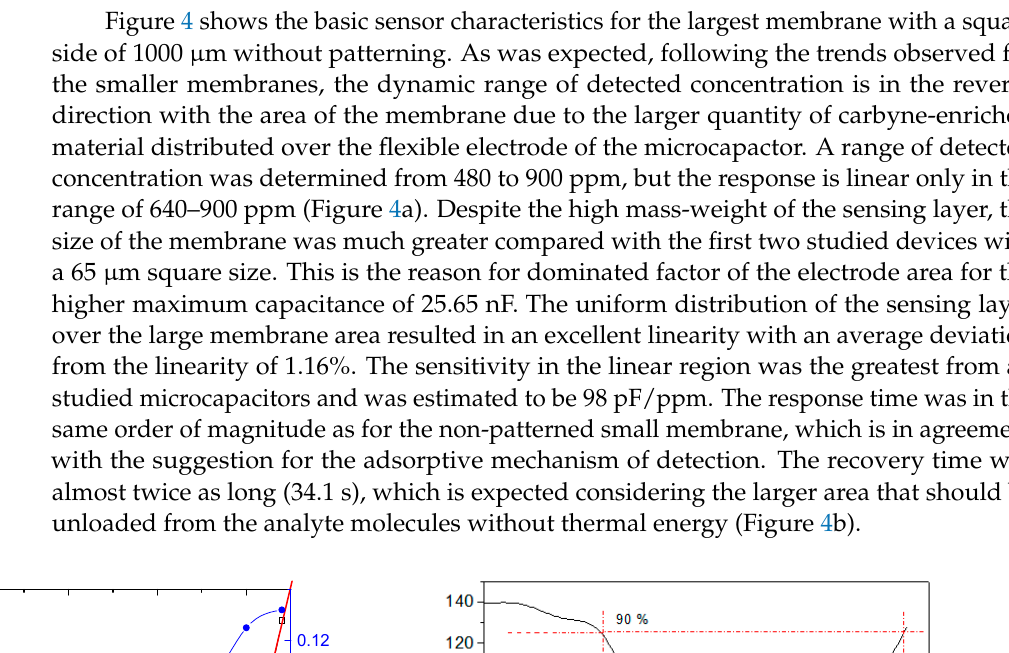
Figure 3. Response of the sensing device with the small non-patterned membrane: ( a ) capacitance and loss tangent changes with the ethanol concentration; ( b ) sensing layer resistance change with the time for response and recovery time determination at 750 ppm.